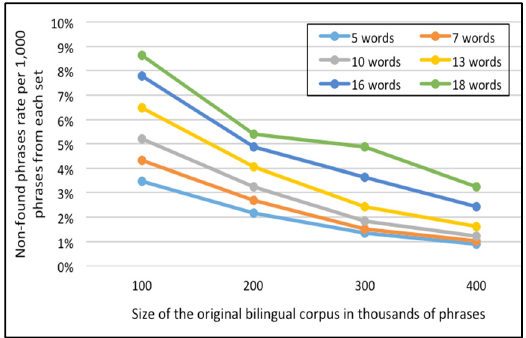
Figure 11. Error rate per 1000 phrases of each set, for the English-French